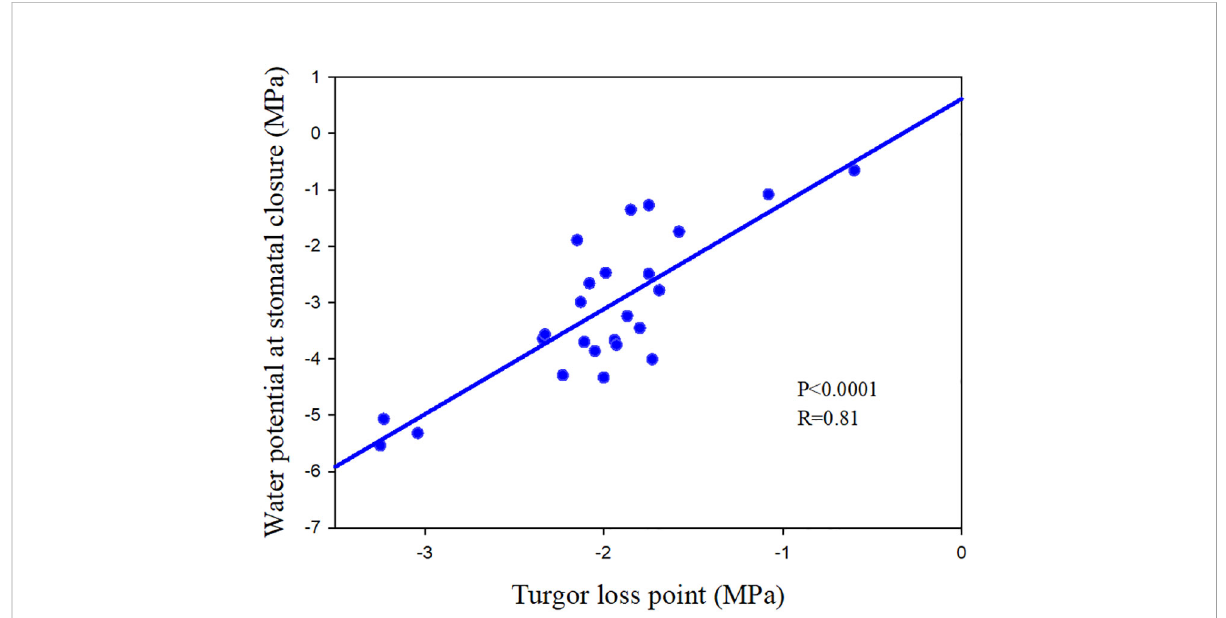
FIGURE 1 The relationship between turgor loss point and the water potential at stomatal closure of 25 angiosperm speices. The data comes from Chen et al. (2021b) and Li et al.